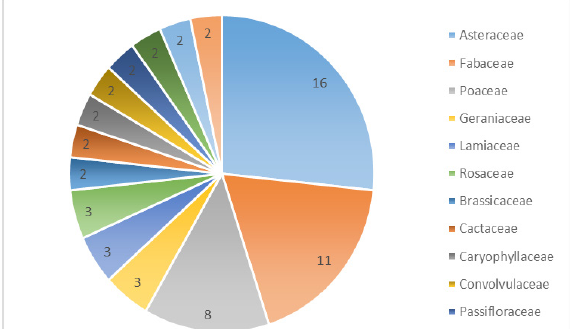
Figure 5. Main plant families and their richness recorded in the plots of early post-agricultural succession in Cajatambo, Lima (2015 to